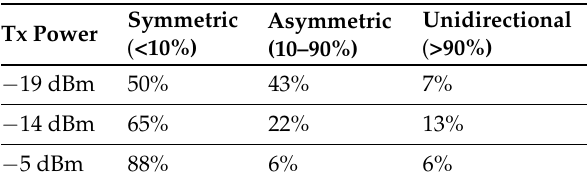
Table 1. Link asymmetry in different power level